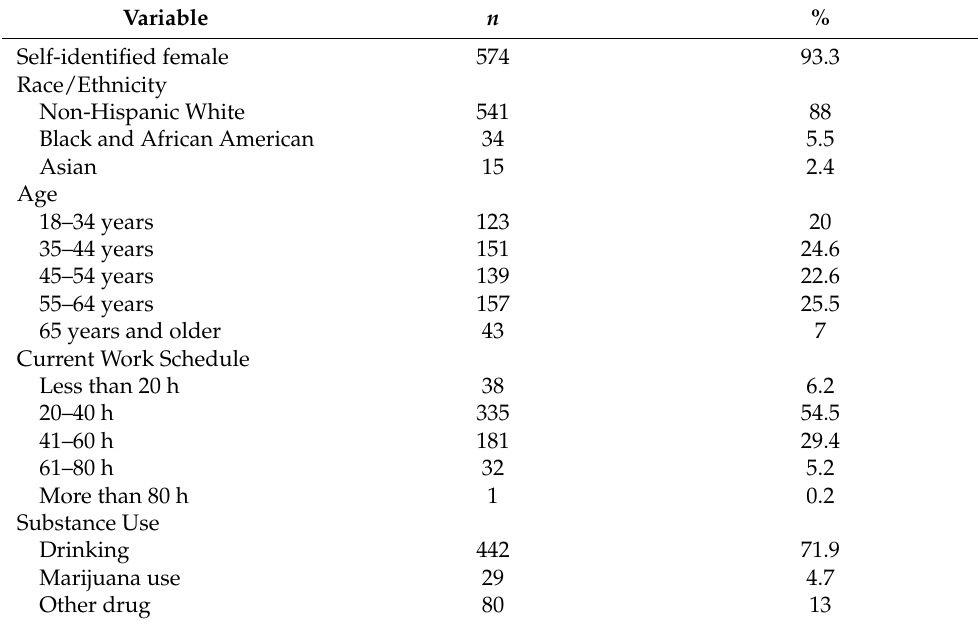
Table 1. Demographic description of the sample.